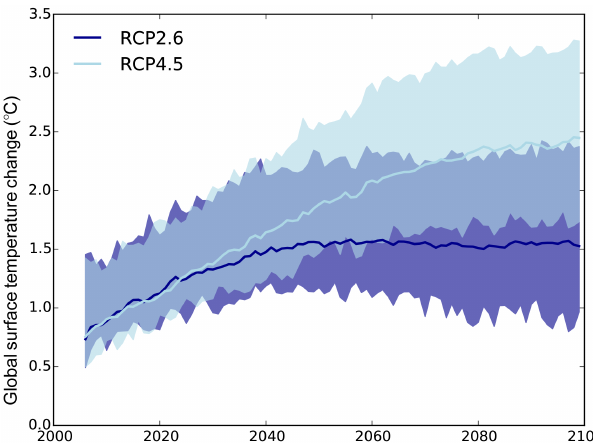
Figure 2. Time series of global annual mean surface-air tempera- ture anomalies (relative to 1861–1880) from CMIP5 RCP2.6 and RCP4.5 experiments. Solid lines show the multi-model mean and shaded regions show the 5–95% range across all 26 models. Only one simulation is used for each model. All models where the data were available for both scenarios were used, leading to 26 models in